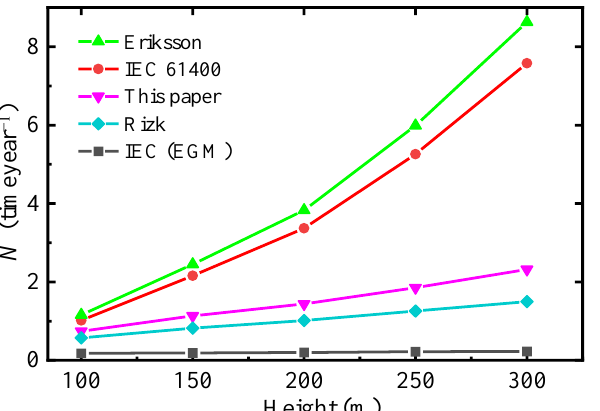
Figure 12. The annual lightning flash number for the wind turbines at different heights by +CG (dashdot line), − CG (dash line) and all the downward lightning (solid line).